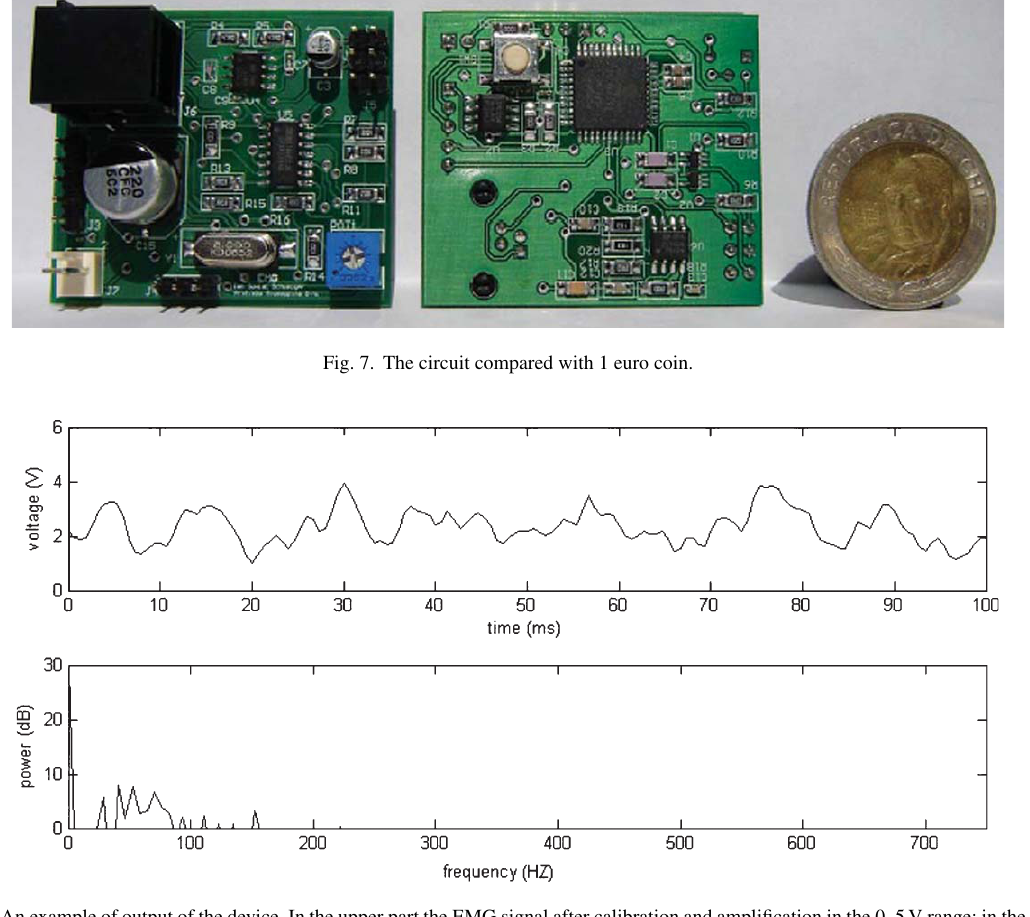
Fig. 8. An example of output of the device. In the upper part the EMG signal after calibration and amplification in the 0–5V range; in the lower part the principal frequency components are